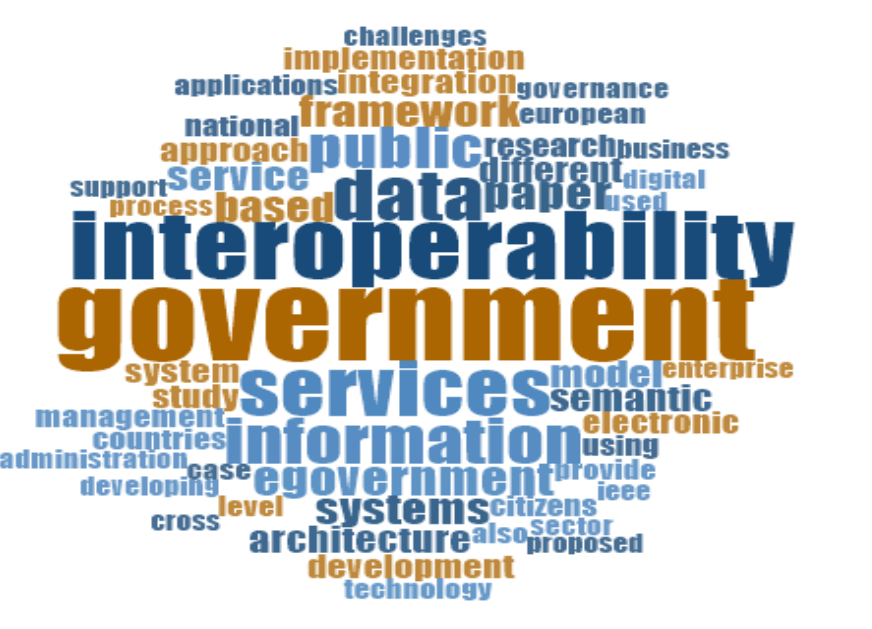
Figure 7: Dominant Issues in Interoperability Studies. Source: Processed by the author using Nvivo 12